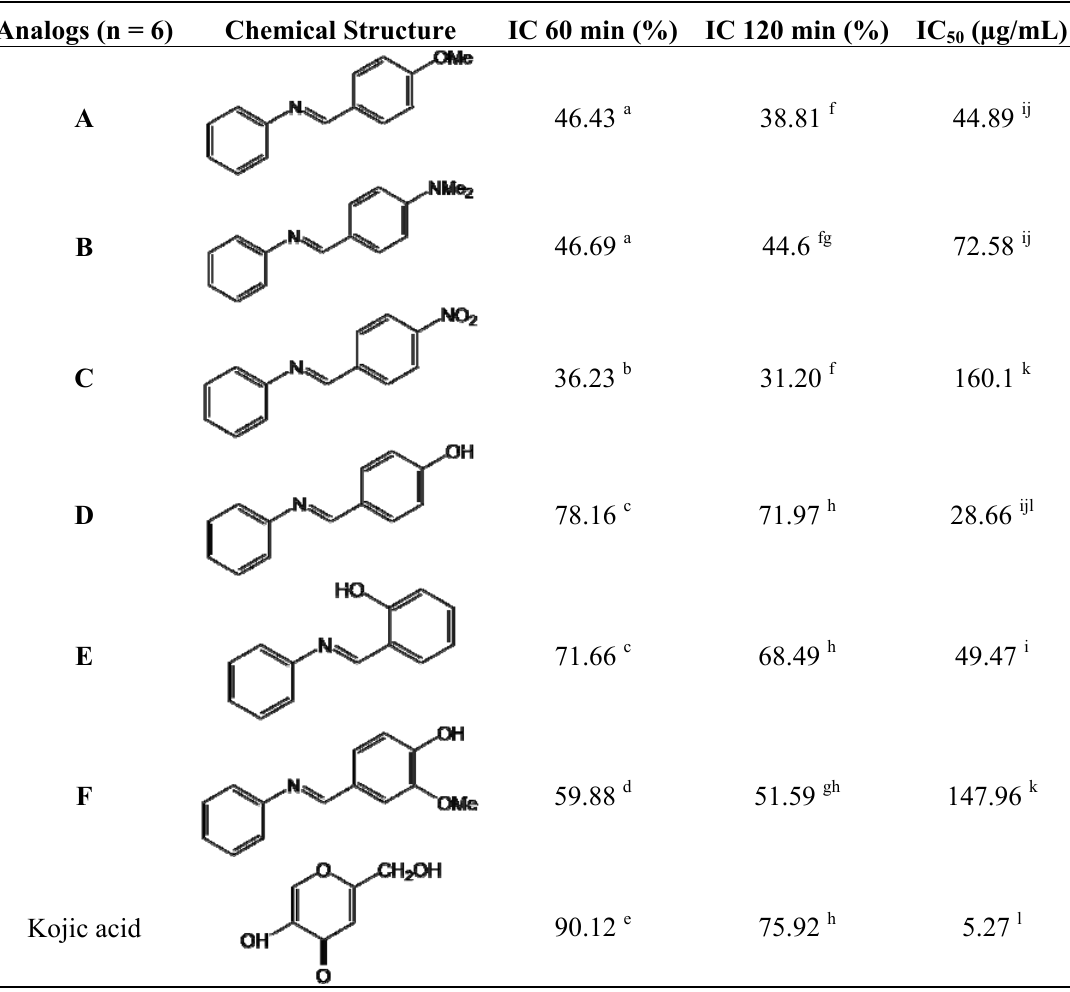
Table 1. Tyrosinase inhibitory activity of azaresveratrol analogs and kojic